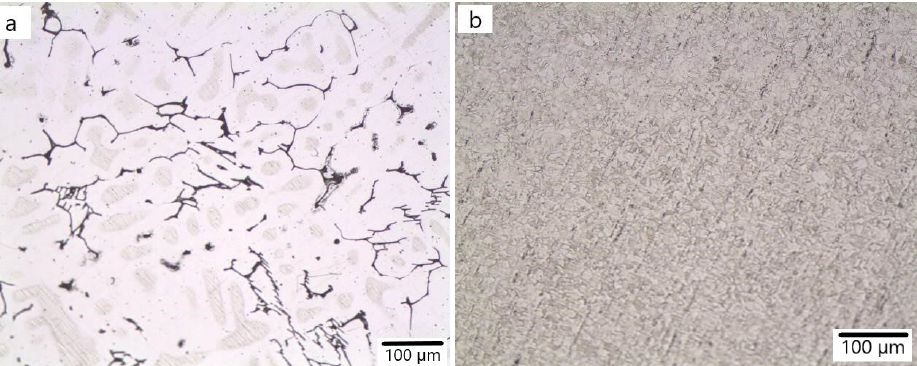
Figure 3. Optical Microscope Images of 316L samples. ( a ) Microstructure image taken from the Investment Casting sample. ( b ) Microstructure image taken from commercial